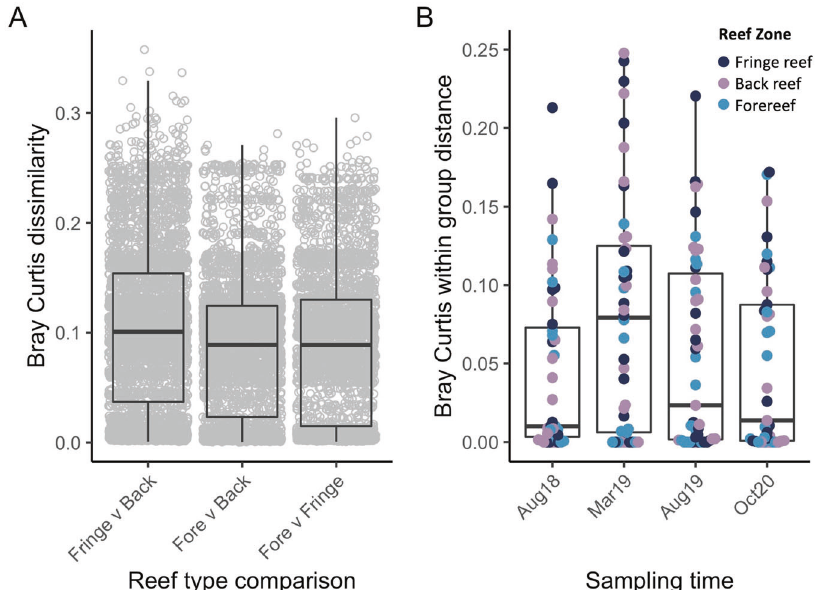
Fig. 5 Bray-Curtis beta diversity metrics of dinoRNAV mcp aminotypes from Porites lobata-Cladocopium C15 colonies varied by reef type and sampling time on the reefs of Moorea, French Polynesia (South Paci fi c). A Between-group distances (composition) varied by reef type, with the fringe and back reef differing the most. The boxplot displays Bray-Curtis distances of dinoRNAV mcp aminotypes from samples of each pairwise combination of reef types. Each dot represents the Bray-Curtis distance between a sample from one reef type and a sample of another reef type. B Within group distances (dispersion) varied across sampling timepoint. The boxplot displays mean within-group distances of dinoRNAV mcp aminotypes for each sample, separated by sampling timepoint. Each dot represents one sample; dots are colored according to reef